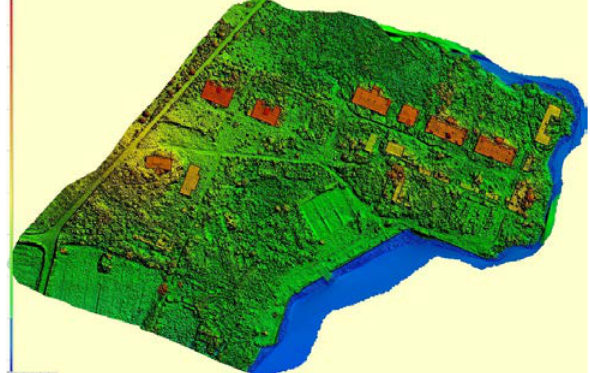
Figure 7. DSM model